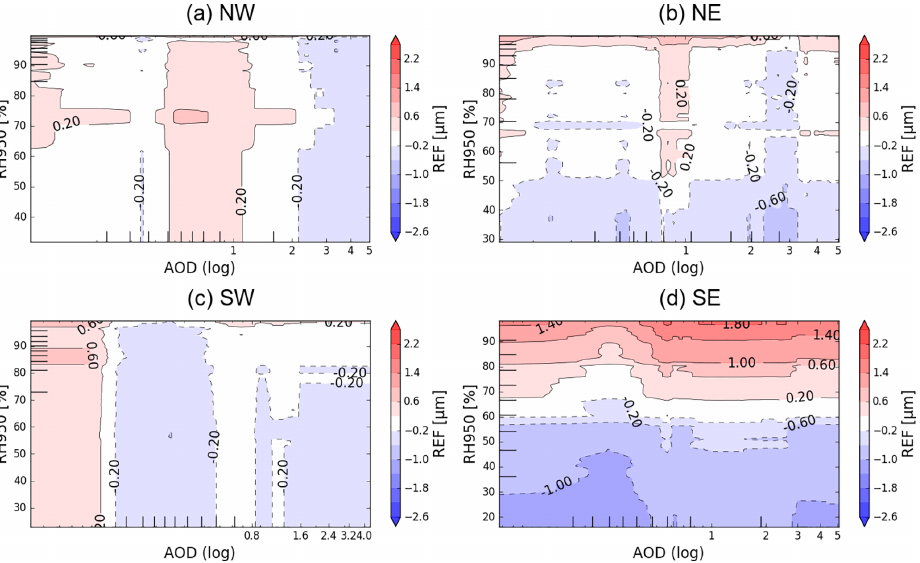
Figure 11. Two-variable partial dependence of REF on RH950 and AOD in the four subregions NW (a) , NE (b) , SW (c) and SE (d) during JAS. Description as in Fig.